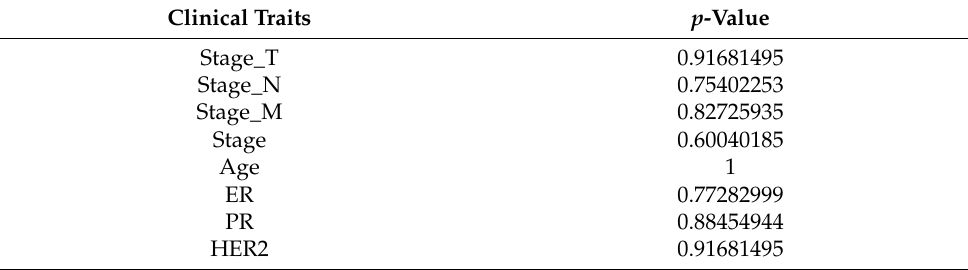
Figure 5. Sample clustering based on phagocytic factors. ( A – C ) Clustering results and parameters of unsupervised clustering, ( D ) PCA of phagocytosis factors, ( E ) expression of phagocytic factors and distribution of related clinical information among different clusters, ( F ) prognostic differences between the two groups, and ( G ) association of phagocytic subsets with related clinical features. Table 2. Statistical test of clinical characteristics among